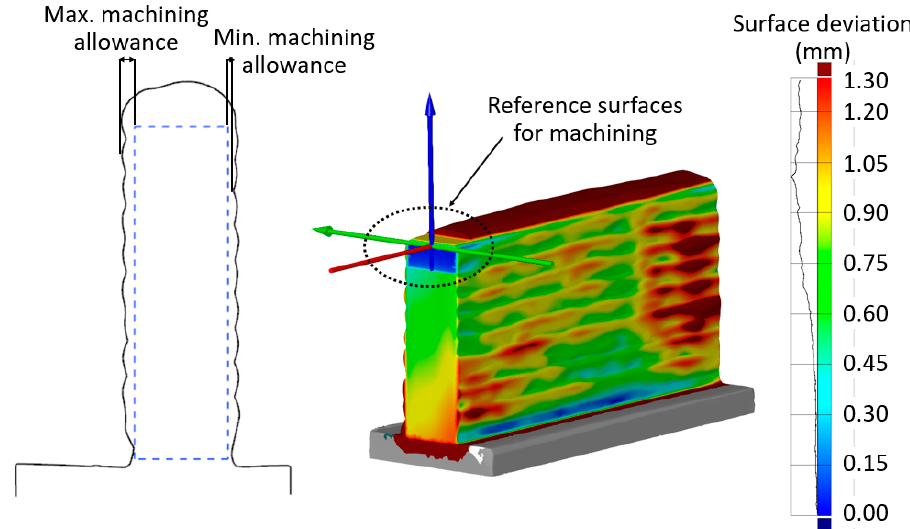
Figure 4. Pre-alignment used for the machining allowance calculation and a 3D model showing the maximum and minimum deviations. Table 4. Machining allowances calculated based on the 3D scanning results. Table 3. Milling parameters used for CRS and SS. Sample No.